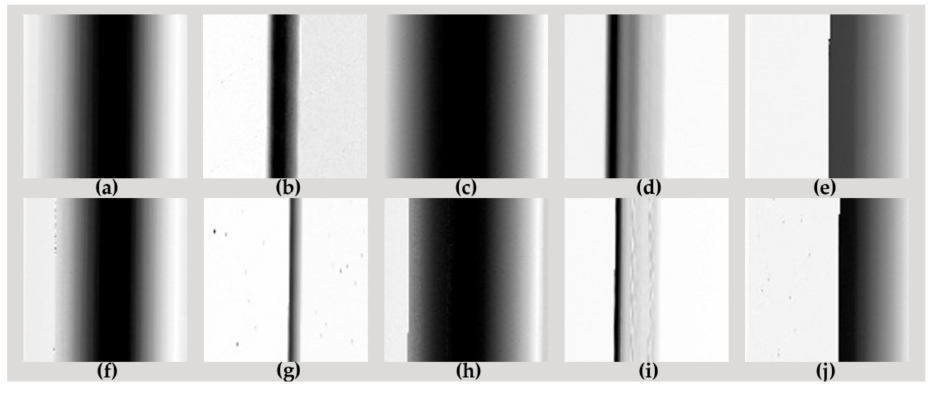
Figure 5. Normal and arc gray image before filtering. ( a ) Vacuum cleaner_Normal; ( b ) Computer_Normal; ( c ) Heater_Normal; ( d ) Fluorescent lamp_Normal; ( e ) Dimmer_Normal; ( f